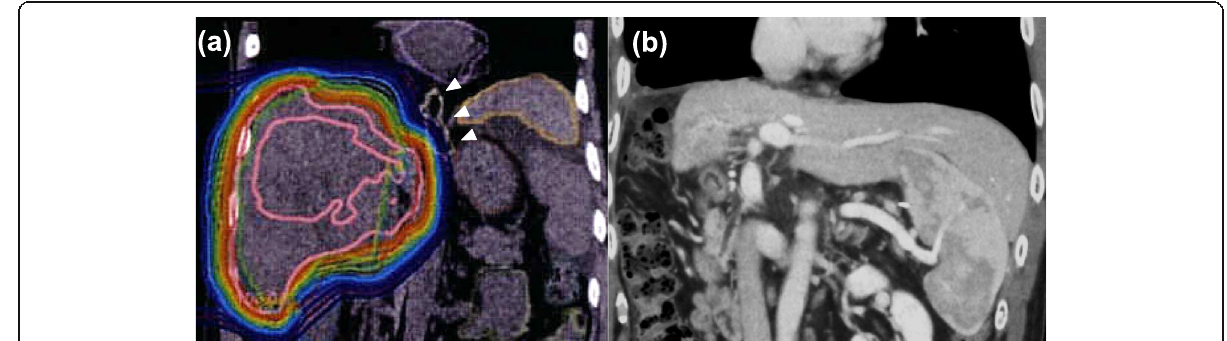
Fig. 2 Dose distribution during proton beam therapy planning and CT findings after the therapy. a Dose distribution during proton beam therapy planning. The white arrowheads indicate the esophagus. b At 5 months after the administration of 66 GyE proton beam therapy in 10 fractions on the primary hepatocellular carcinoma with portal vein tumor thrombosis in the main trunk, CT was done, and the outcome was graded as a complete response, according to the RECIST